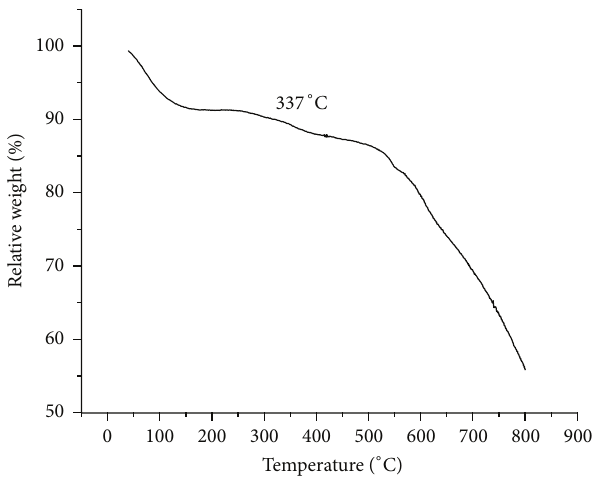
Figure 2: The TG curve of compound 2 .